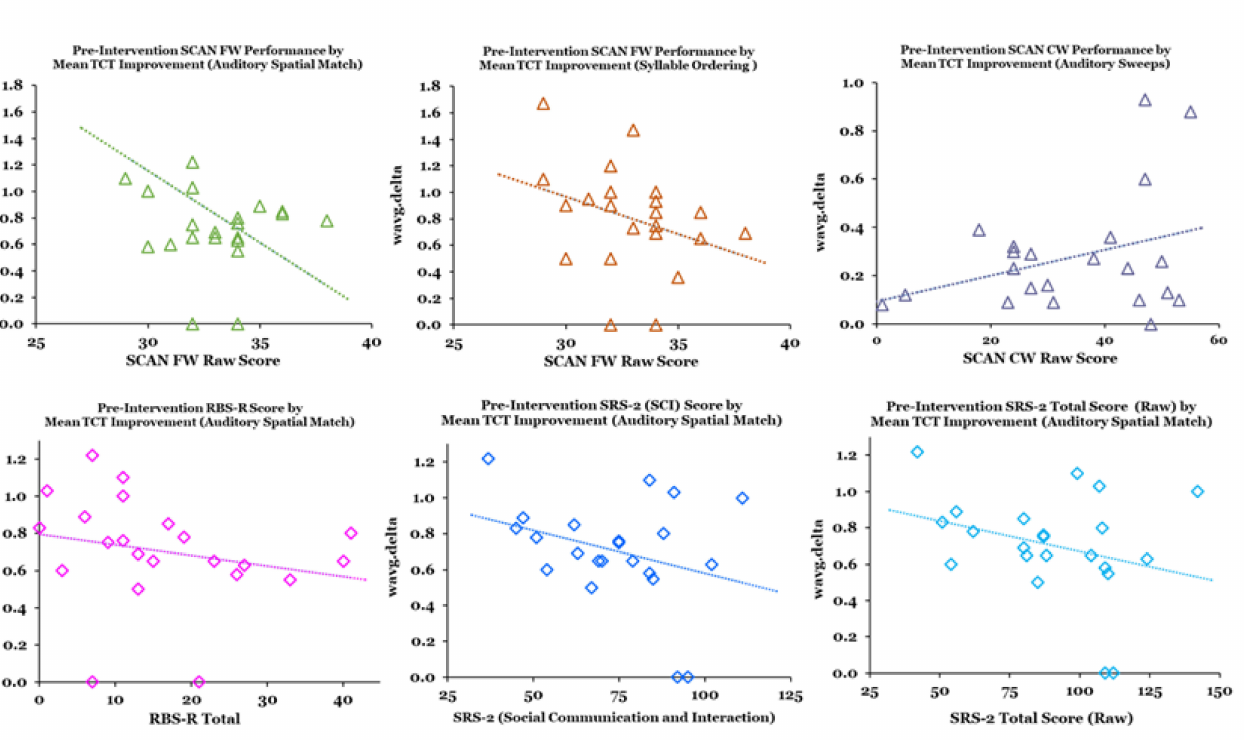
Figure 6. ( A ) Significant ( p < 0.05) partial correlations between mean TCT exercise improvement (wavg.delta) and Pre-Intervention SCAN Performance Scores. ( B ) Trend-level partial correlations be- tween mean TCT exercise improvement (wavg.delta) and Pre-Intervention clinical assessment